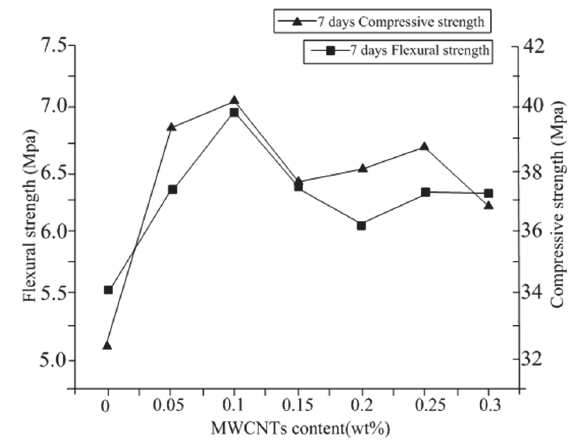
Figure 3: Mechanical properties of cement-based composite materials test specimens which were mixed with different amount of carbon nano-tubes after seven days of